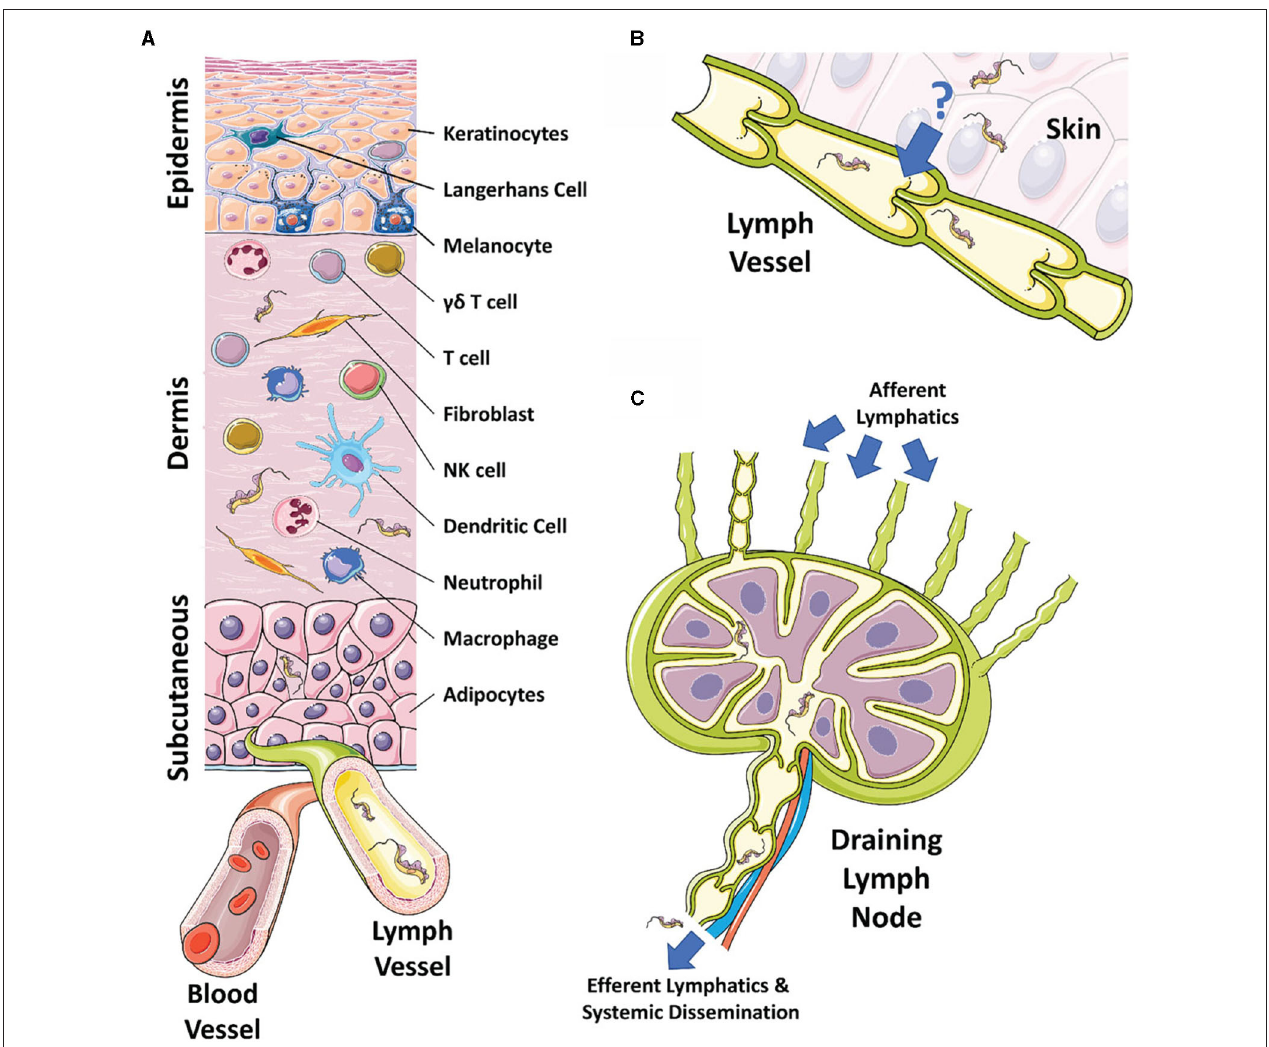
FIGURE 1 | The skin, draining lymphatics, and lymph nodes. (A) Diagram of the cellular composition of the epidermal, dermal, and subcutaneous layers of mammalian skin. The outermost epidermal layer consists of a layer of corneocytes above a layer of keratinocytes. These cells manage the tight junctions and the stratum corneum. Langerhans cells and intraepithelial T cells survey the epidermis for antigen to be presented. The central dermal layer contains fibroblasts that produce extracellular matrix proteins to provide structural support and elasticity. Immune responses are initiated by dermal macrophages, dermal dendritic cells, NK cells, and T cells. The inner subcutaneous layer primarily consists of adipocytes. Local lymphatic and blood vessels allow for the trafficking of cells, proteins, and waste. The initial tsetse fly bite injects trypanosomes into the dermis. From the dermis, the parasites exhibit tropism that leads to migration toward the afferent lymph vessels in the skin disseminating to the blood and other regions of the body. (B) The mechanism behind directional migration of trypanosomes from the skin to the lymphatics is unknown. Parasites may be responding to an unreported chemical cue in a chemotactic manner and they may crawl along lymph vessels, access open junctions, or are drawn into the lymphatics through hydrodynamic flow force and pressure. (C) Afferent lymphatic vessels in the skin allow for the drainage of leukocytes and antigen into the draining lymph node. Lymph, containing activated T and B cells, plasma cells, and antibody, passes into the medullary sinus, before exiting via efferent lymphatic vessels. Trypanosomes enter the draining lymph nodes, causing lymphadenopathy, and exit via the efferent lymphatics. Systemic dissemination of the host is reached via the main lymphatic ducts.